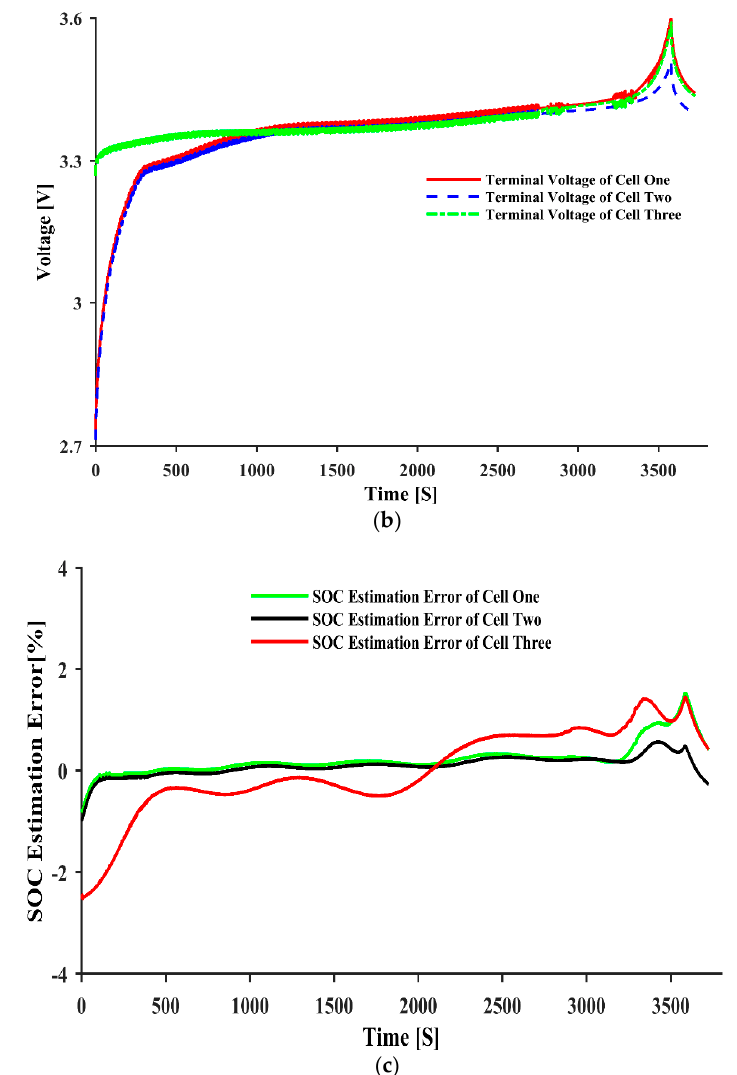
Figure 7. Pack balancing performance in charging process with the SOC as the balancing criterion. ( a ) experimental results for estimated SOCs of three cells during charging process; ( b ) experimental results for terminal voltages of three cells during the charging process; and ( c ) SOC estimation errors of three cells during charging process.